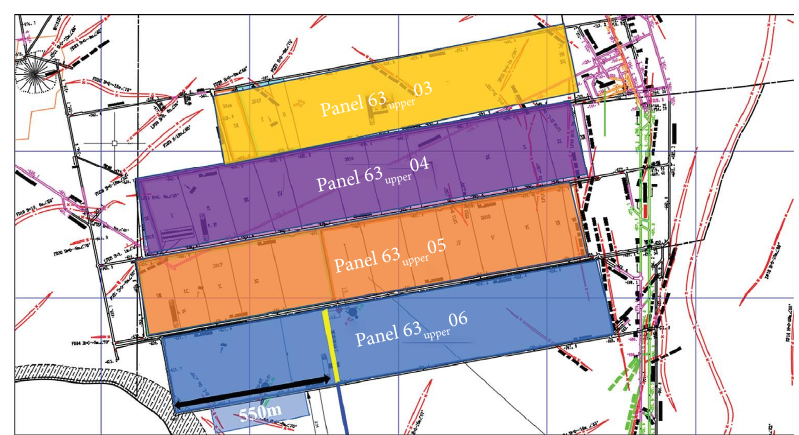
Figure 1: Te division of panels in No.6 mining area.